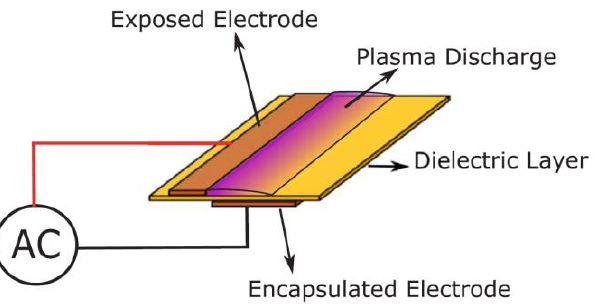
Figure 6. Schematic of the conventional surface dielectric barrier discharge plasma actuator (repro- duced from Rodrigues et al. [98] with permission of Elsevier).